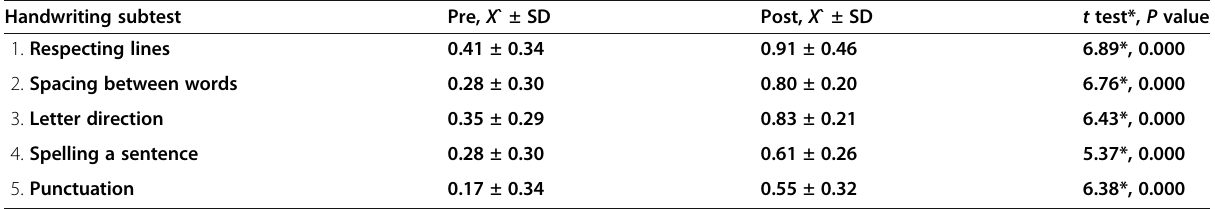
Table 4 Comparison of total mean scores between the pre-training and post-training results regarding the handwriting subtest in the dysgraphia disability scale ( N , 20 cases) (done by paired sample t test)